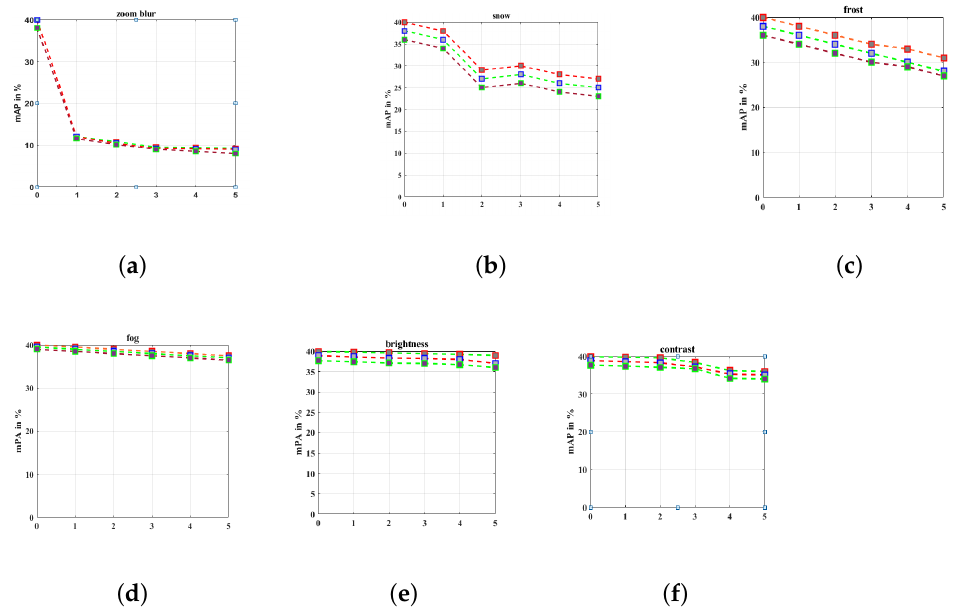
Figure 5. The performance of the camera influenced by different corruptions ( a ) zoom blur ( b ) snow ( c ) frost ( d ) fog ( e ) brightness ( f )